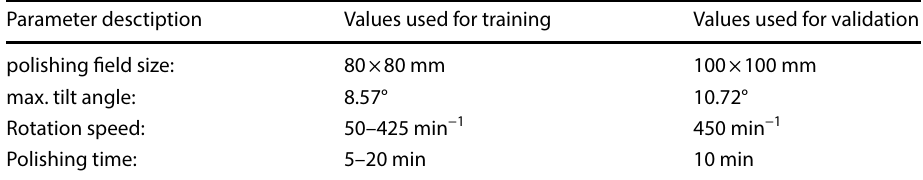
Table 4 Comparison of the training parameters to the validation parameters